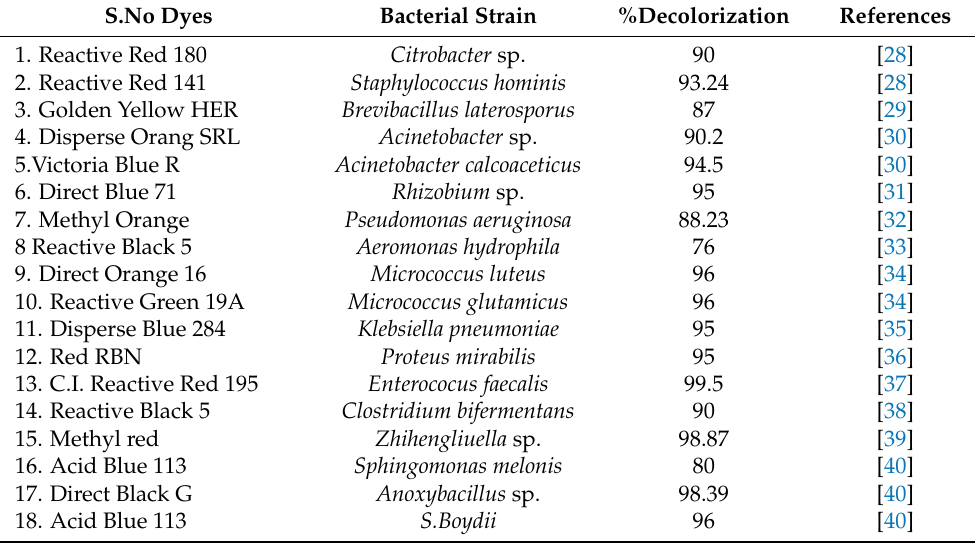
Table 1. The decolorization potential of different bacterial strains for